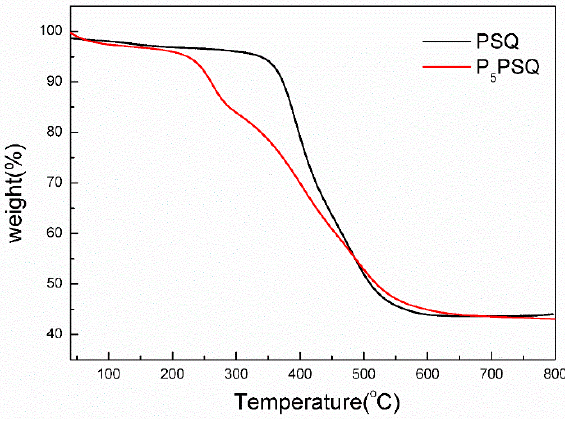
Figure 3. TGA curves of PSQ and P 5 PSQ under nitrogen.